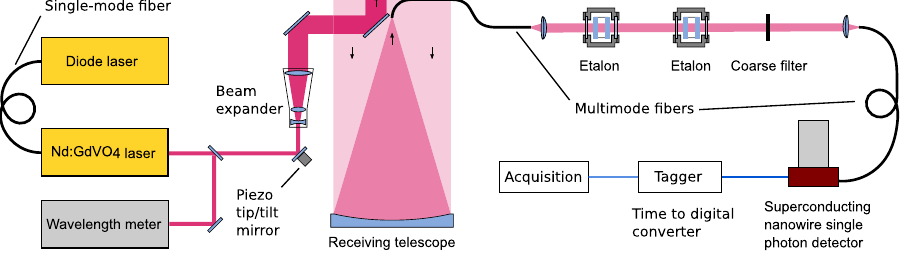
Fig. 4 |Simpli fi edschematic ofthehelium lidar. The Nd:GdVO 4 laser, seeded by the continuous wave diode laser, emits narrow-band laser pulses at 1083nm wavelength, which are released into the atmosphere. Backscattered light